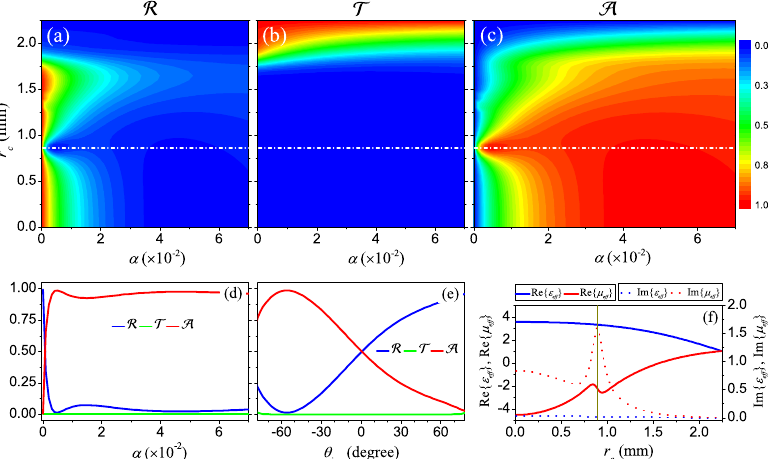
Figure 4. R ( a ), T ( b ), and A ( c ) are plotted as the functions of damping factor α and the inner radius r c of hollow core for the MM slab of type II at a fixed incident angle θ inc = − 55 ◦ . The spectra are plotted as the functions of the damping factor α ( d ) and the incident angle θ inc ( e ) for the optimized core radius r c = 0.88 mm. ( f ) The effective permittivity ε ef f and effective permeability µ ef f are plotted as the functions of core radius r c at a fixed damping factor α = 5 × 10 − 3 . The BMF is H 0 = 600 Oe, the working frequency is f = 4 GHz and the other parameters are the same as those in Figure